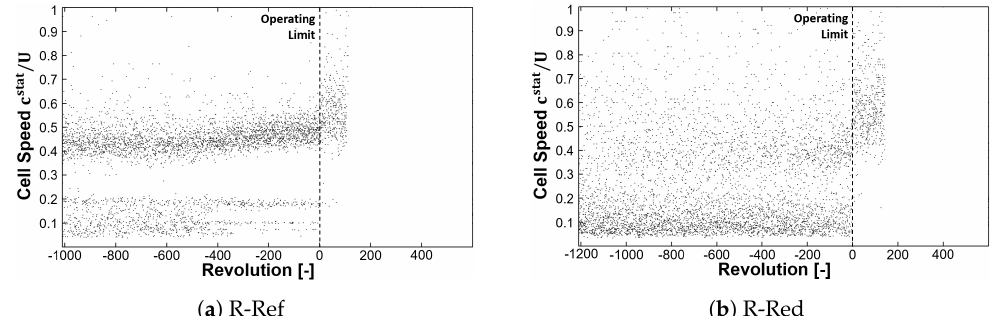
Figure 6. Propagation Speed of Aerodynamic Disturbances at Design Speed.